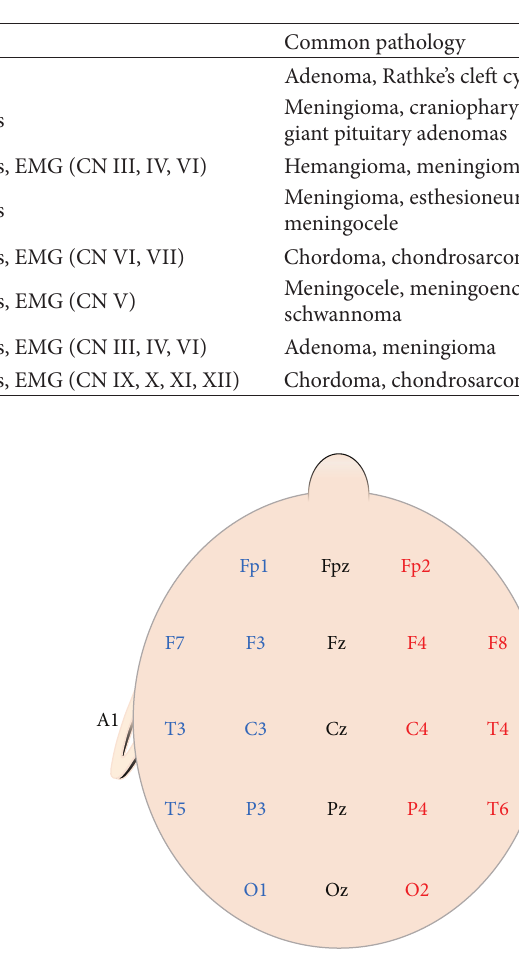
Table 1: Surgical approaches using the endoscopic, endonasal route and recommended IONM modalities based on pathologies commonly encountered via that approach.